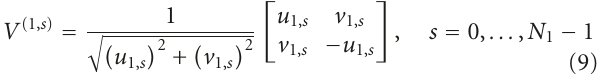
Algorithm 1 (synthesis of H N ∈ Ω with h in the first